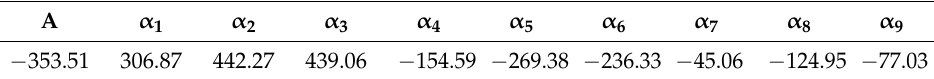
Table 5. The comparison of predicted mean relative error (MRE s).